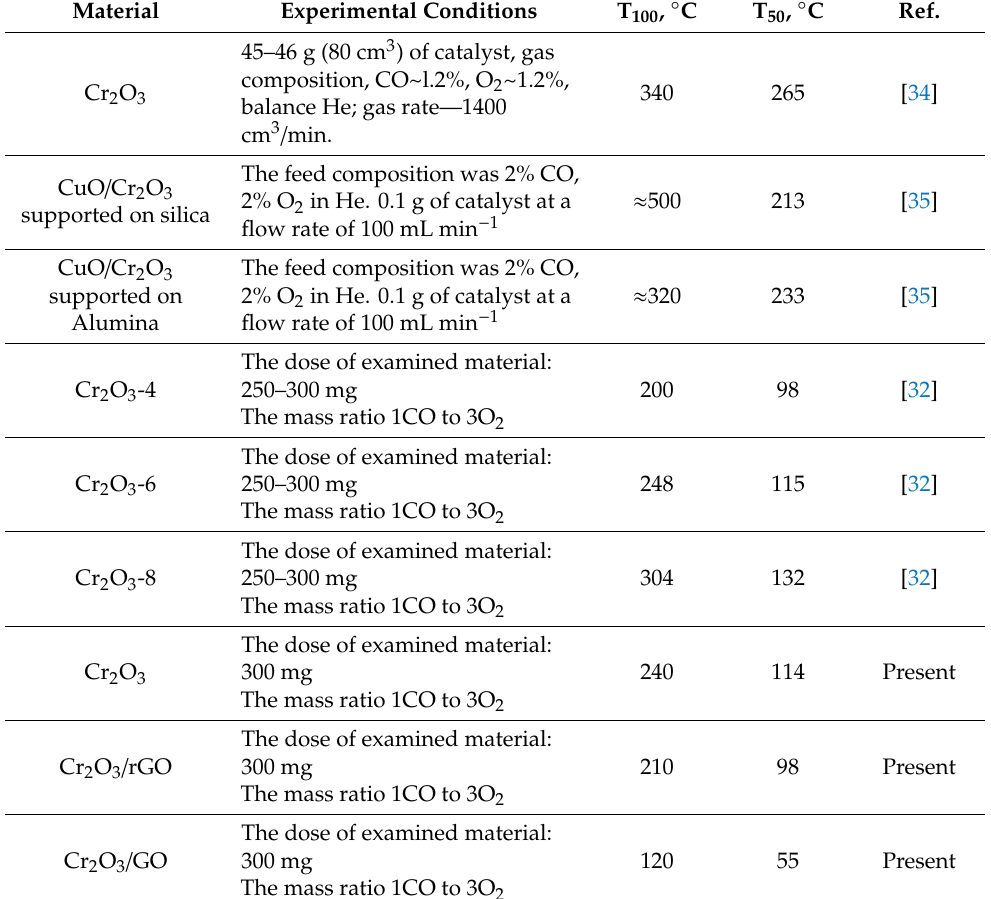
Table 1. T 100 and T 50 for Cr 2 O 3 NPs alone and also for the hybrids Cr 2 O 3 / rGO and Cr 2 O 3 / GO, compared with di ff erent previously reported data on Cr 2 O 3 -based